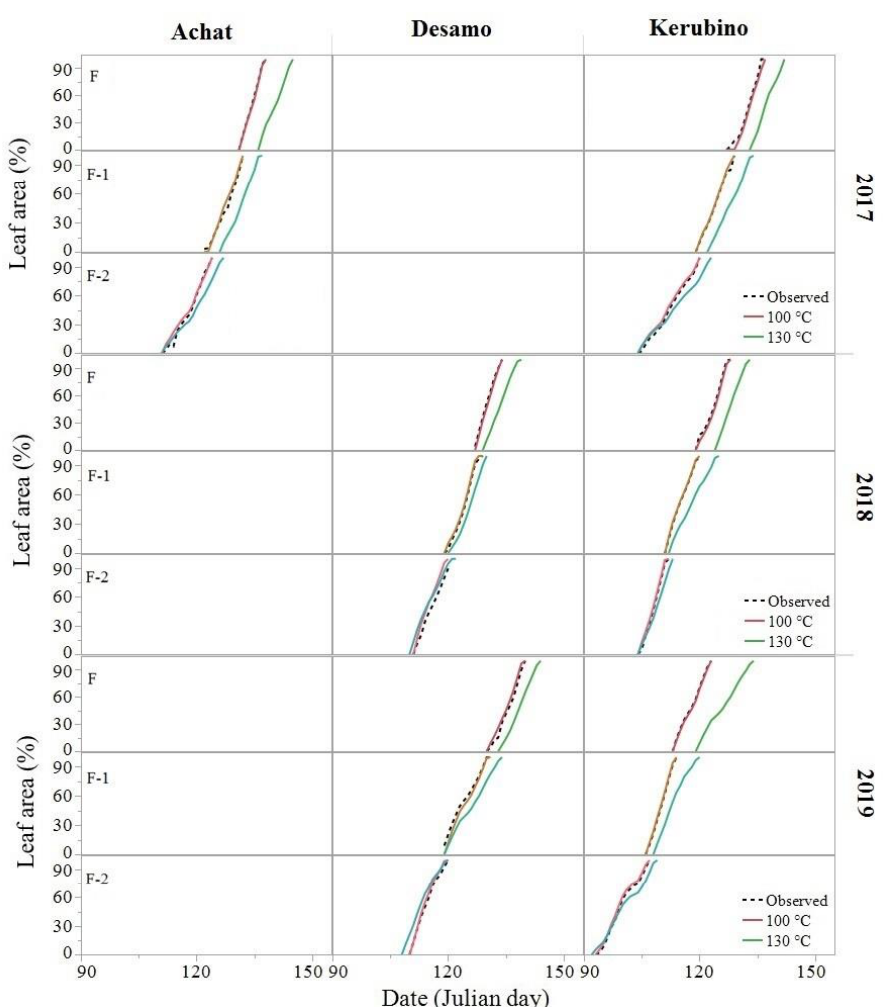
Figure 5. Comparisons between observed and predicted leaf emergence for the three upper leaves (F, F-1 and F-2, F being the flag leaf) for different winter wheat cultivars at Bettendorf during the 2017–2019 cropping seasons. Only results for the default phyllotherm in PROCULTURE (130 °Cd) and phyllotherm 100 °Cd are presented. Note: the curves for observed values and predicted values using the 100 °Cd phyllotherm appear superposed in some of the graphs.